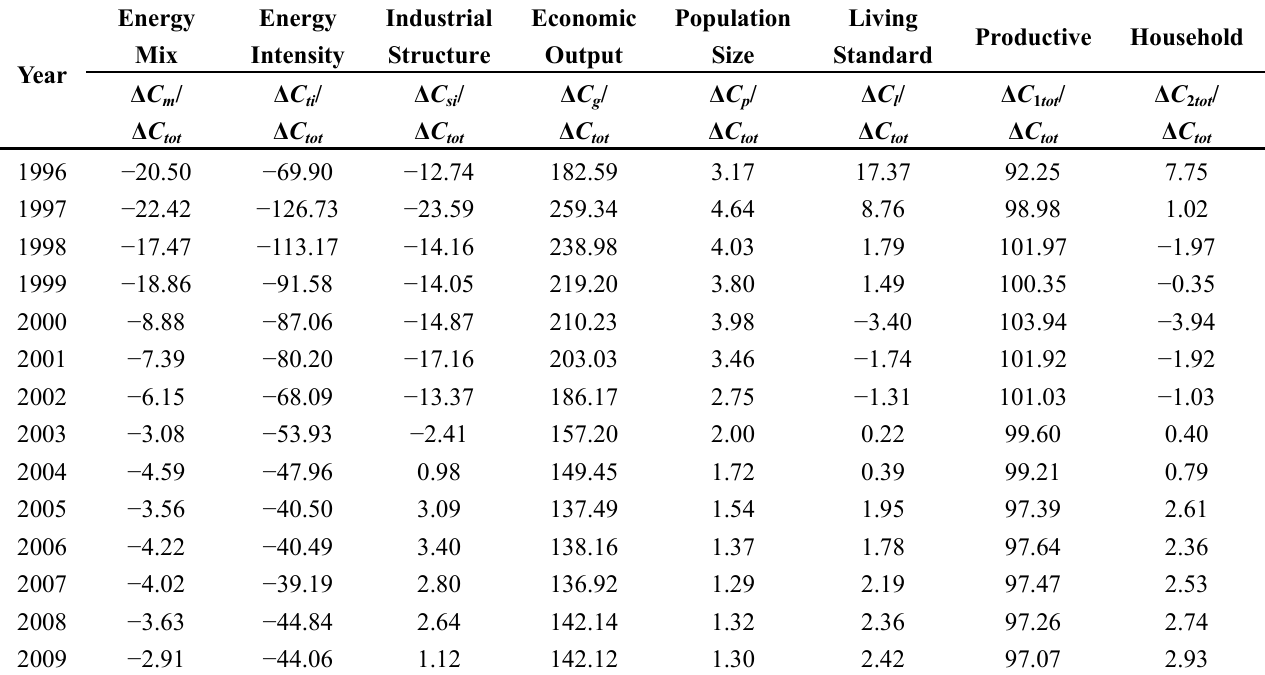
Table A5. Contribution rate of each decomposed factor to energy-related carbon emission (%).